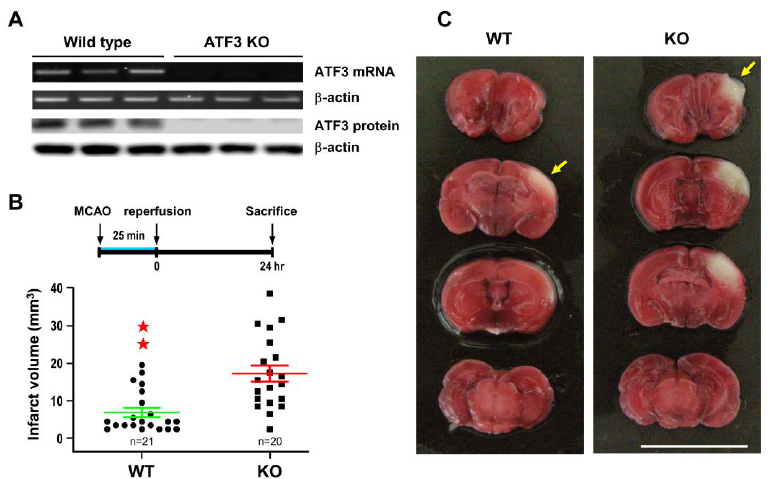
Figure 3. ATF3 knockout (KO) exacerbates ischemic brain injury. ATF3 KO mice were subjected to 25 min of ischemia and infract volume was determined at 24 h of reperfusion. Three wild type and three KO mouse brains were used in RT-PCR analysis; and another set of three wild type and three KO mouse brains were used in Western blot analysis. Each band represents a data point that was extracted from an independent brain sample and no replicates. Representative RT-PCR and Western blots of ATF3 mRNA and protein in the ischemic cortices ( A ). Brain infarct volume in KO and wild type (WT) mice after 25 min of ischemia and 24 h of reperfusion ( B ) and representative images of brain infarct ( C ). Each dot represents a data point from an individual animal. Data are expressed as mean ± SD ( n ≧ 6). ★★ p < 0.01 vs. control. ATF3: activating transcription factor 3; MCAO: middle cerebral artery occlusion.